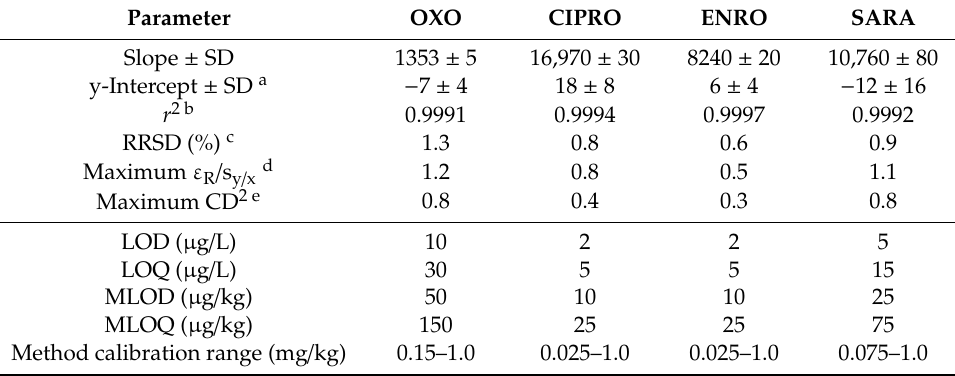
Table 2. Calibration and sensitivity parameters (SD: standard deviation; RRSD: relative residual standard deviation; r 2 : determination coe ffi cient; ε R : residual; s y / x : residual standard deviation; CD: Cook’s squared distance; LOD: limit of detection; LOQ: limit of quantification; MLOD: method limit of detection; MLOQ: method limit of quantification). Parameter OXO